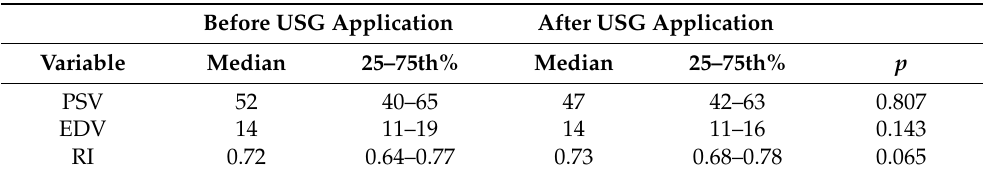
Table 4. Doppler measurements of the patients before and after ultrasound application. Abbrevia- tions: PSV: peak systolic velocity, EDV: end-diastolic velocity, RI: resistive index. Before USG Application After USG Application Variable Median 25–75th%